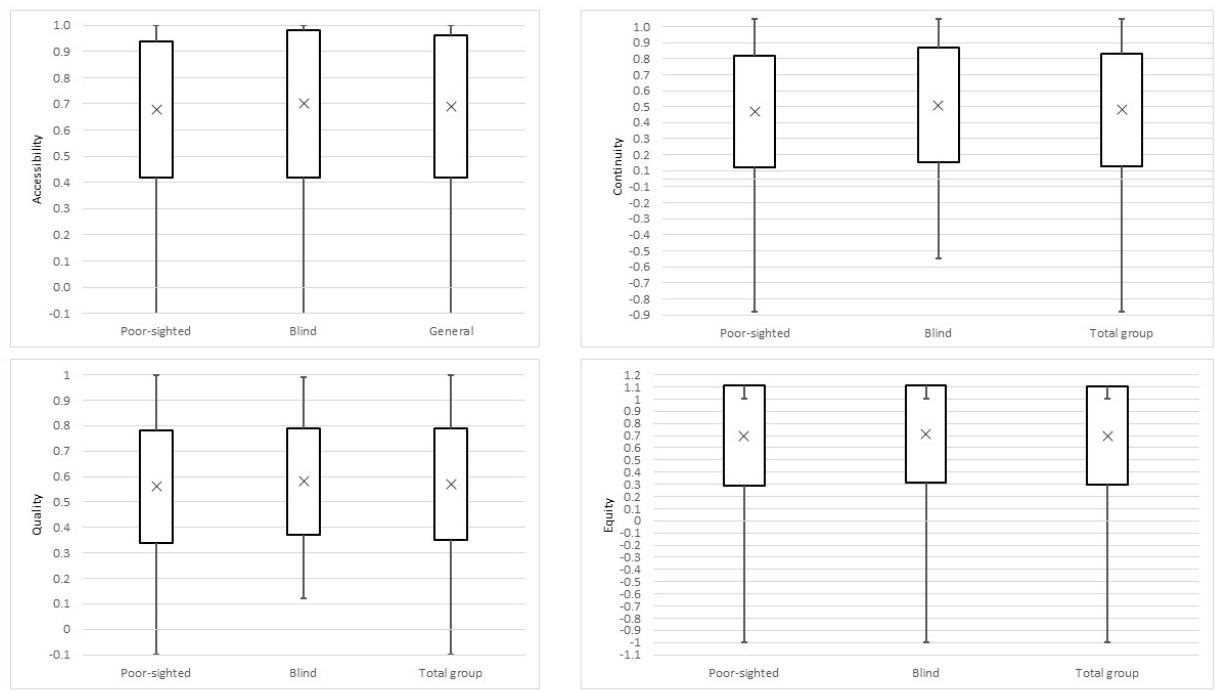
Figure 1. Mean PVIs’ expectations towards four PHC